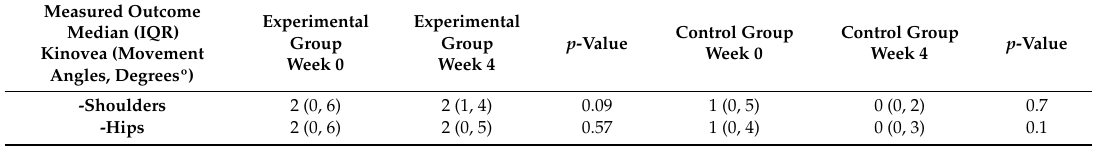
Table 4. Results of postural alignment in the experimental and control